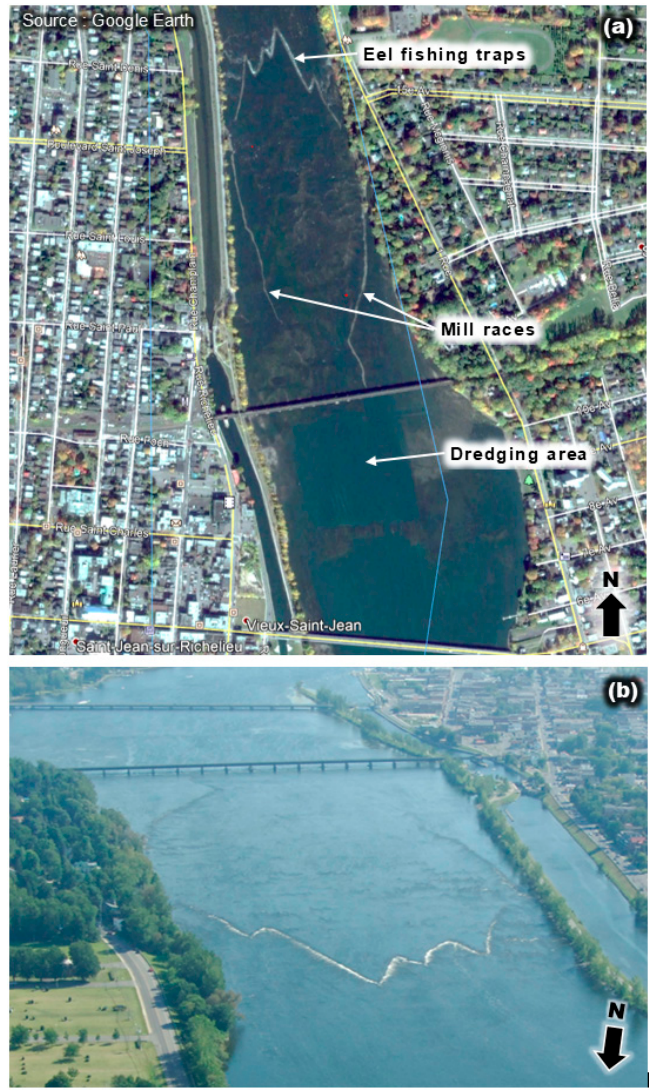
Figure 9 . ( a ) Man-made structures in the Saint-Jean-sur-Richelieu bedrock shoal area. ( b ) Water surface disturbances caused by the remains of eel fishing structures.